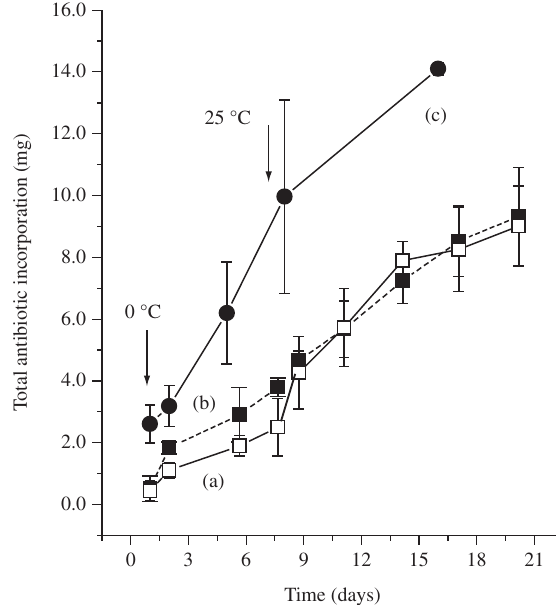
Figure 3. Incorporation profile determined by UV-visible spectroscopy of antibiotics for azide anionic collagen membrane cast from gels equilibrated at